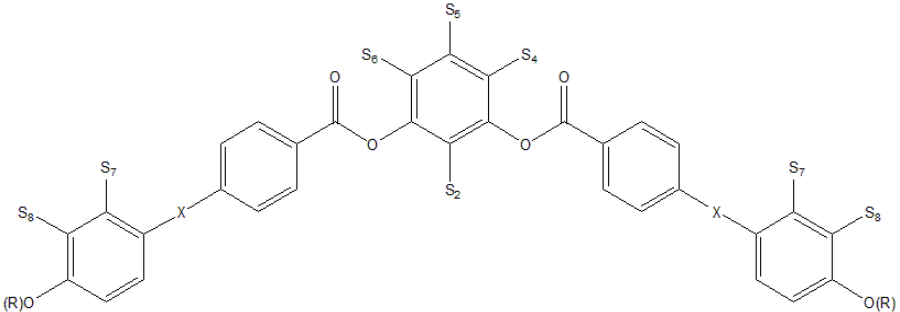
Figure 1. Schematic representation of the investigated bent-core compounds (X — linking group, R — terminal flexible chain). Substituents can be found in positions S2, S4, S5, S6, S7 and/or S8. After data collection and analysis, the final dataset contains 172 bent-core compounds. The dataset consists of compounds with different linking group substituents on the central core and/or calamitic wings and with different types (alkyl or alkoxy group) and lengths of terminal chains. Linking group X is an azo (-N=N-), ester (-OC(=O)-) or imine (-N=CH-) group (Tabel S1). The substituents are, depending on the case, -F, -Cl, -Br, -CN, -CH 3 , -OH or -NO 2 , which can be found in the S2, S4, S5, S6, S7 and/or S8 posi- tions.